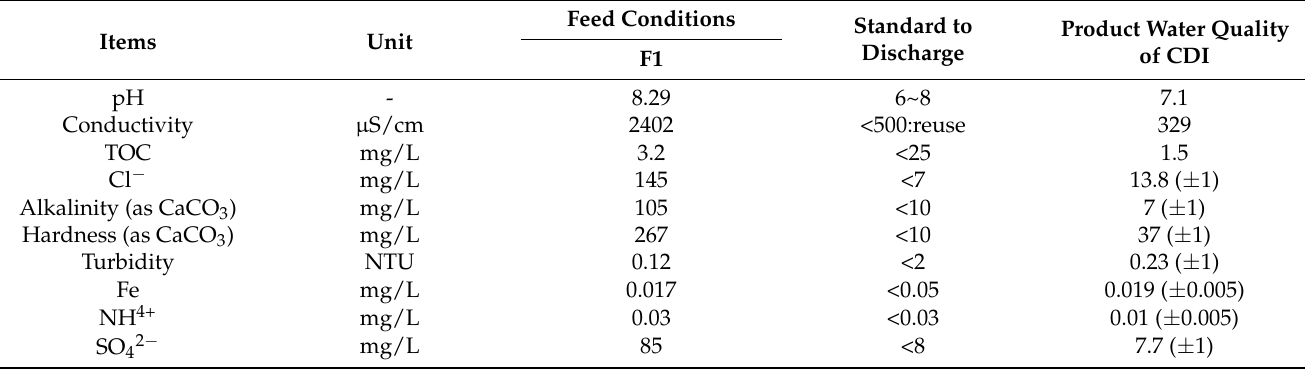
Table 9. Summary of the product water quality and standards of industrial discharge limits using feed solution F1.